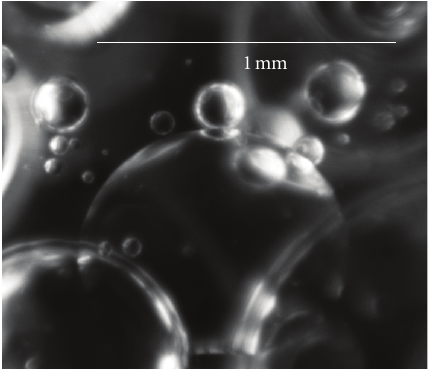
Figure 8: Photo of W/O emulsion at 70% n-dodecane taken with the SOPAT endoscope (SOPATec, Berlin,